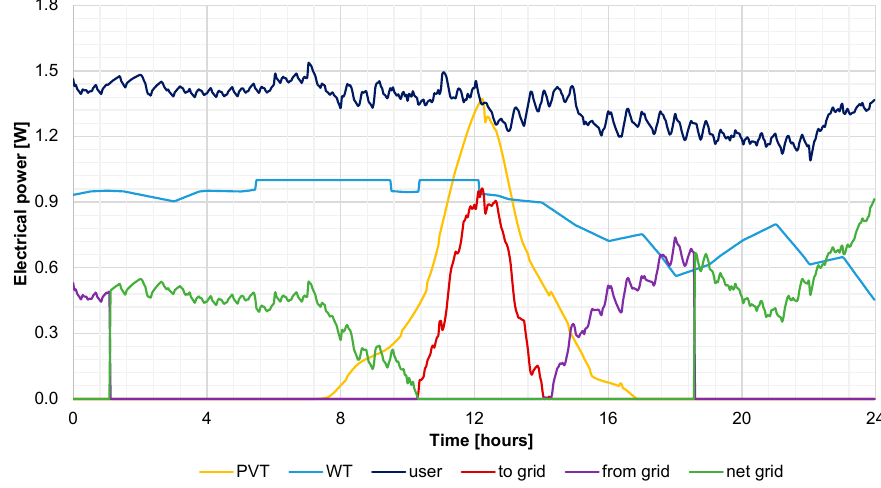
Figure 8. Main electrical powers of the system, daily analysis, winter day.